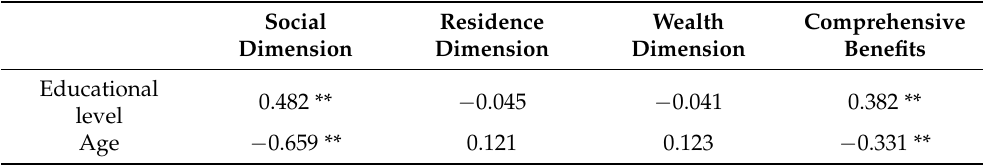
Table 4. Results of Pearson correlation